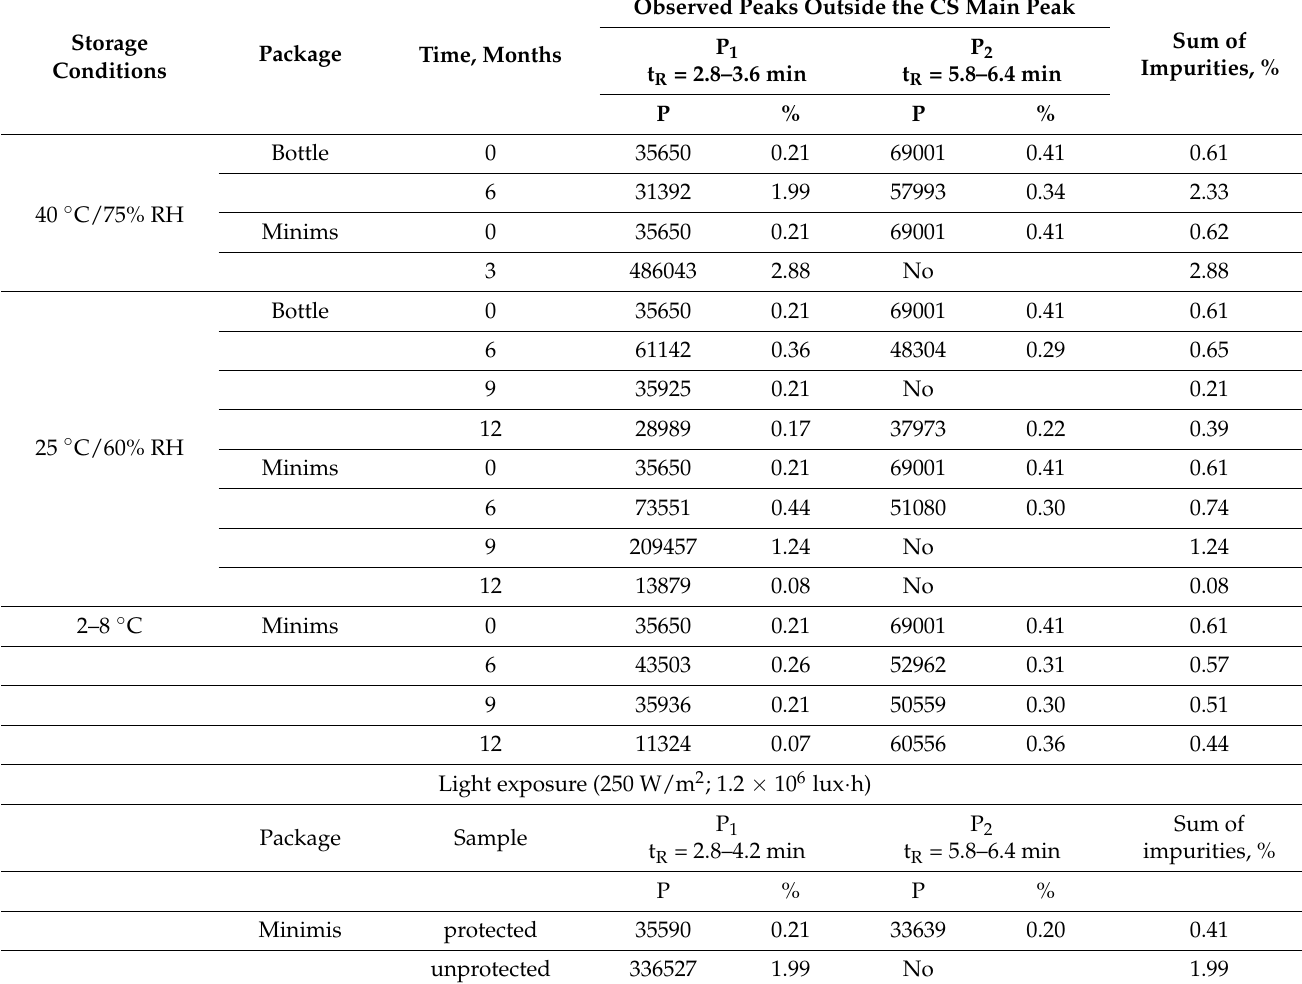
Table 6. Chromatographic (HPLC-UV) purity analysis of CS (2%) with HA (0.4%) eye drops stored in bottles and minims under controlled and uncontrolled conditions, and after exposure to the light, showing the area (P) of the observed peaks (P 1 , P 2 , P 3 ) and the percentage relative to the area of the main peak corresponding to the level of impurities of 0.1% (P 0.1% =